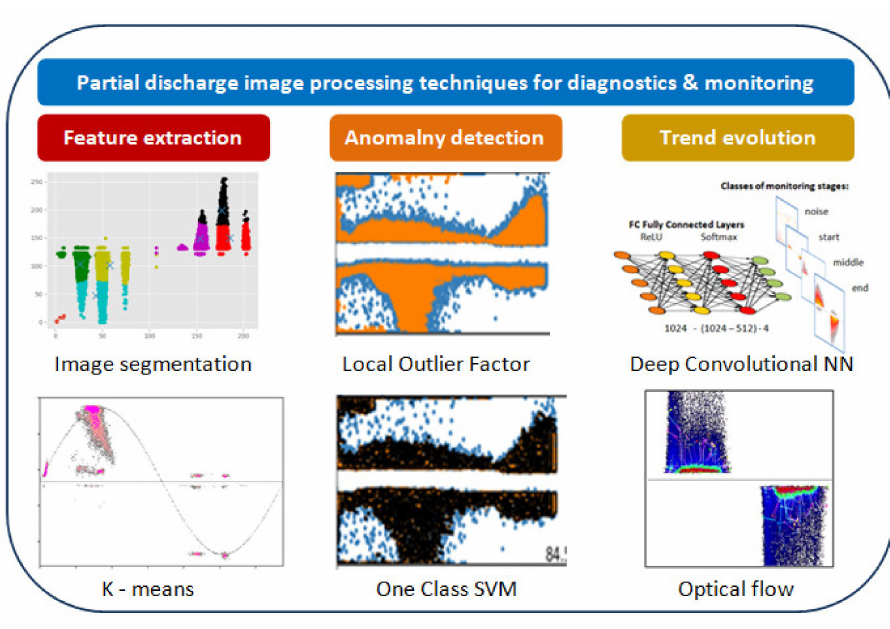
Figure 2. Partial discharge image processing and machine learning techniques for diagnostics and monitoring analyzed in the paper in the following classes: feature extraction, anomaly detection, and trend